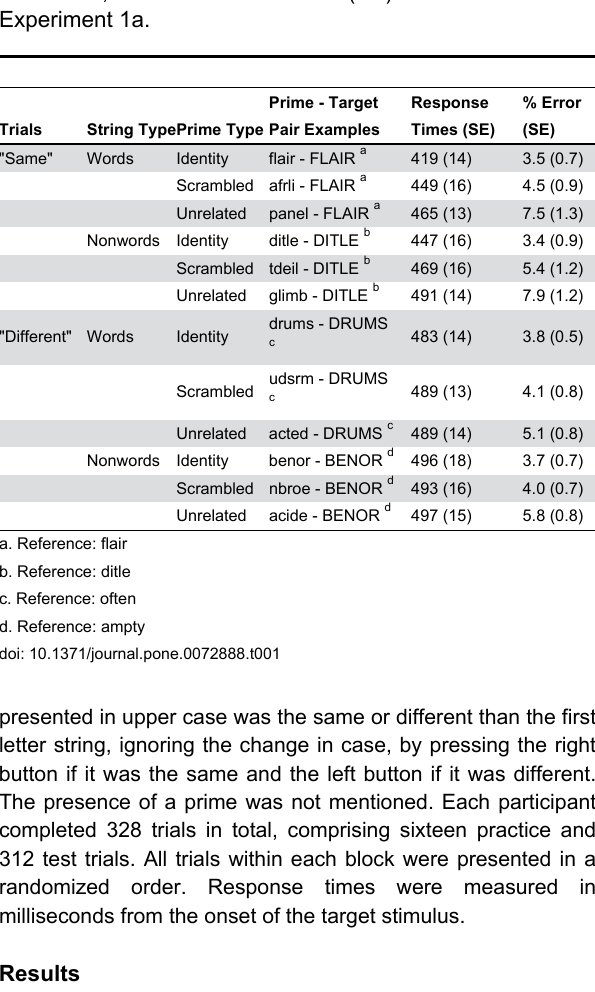
Table 1. Mean response times in milliseconds, percentage error rate, and standard error (SE) of the means of Experiment